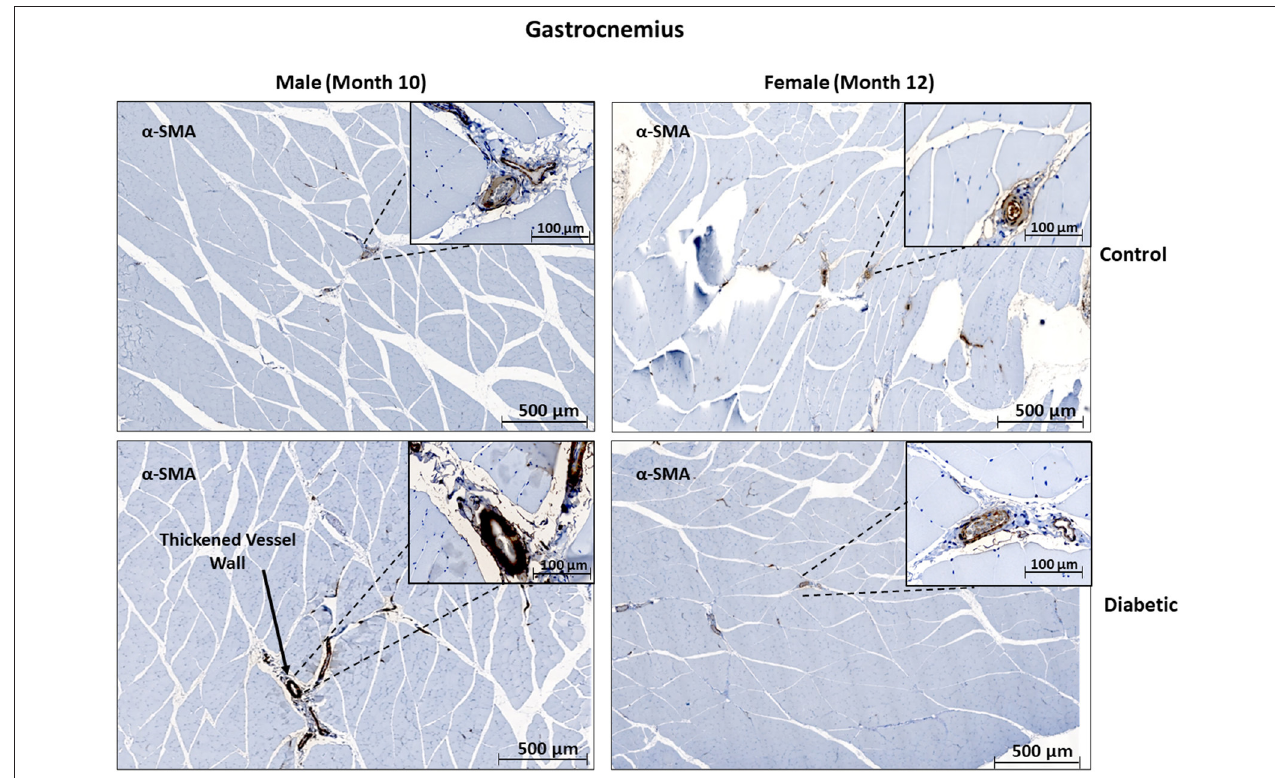
FIGURE 5 | Histology of large arteriole perivascular smooth muscle wall in leg skeletal muscle shows thickening in diabetic males. Representative images of gastrocnemius skeletal muscle sections stained with α SMA in males at 10 months and females at 12 months post-induction. Images depict a thickened perivascular smooth muscle layer in the male diabetic cohort